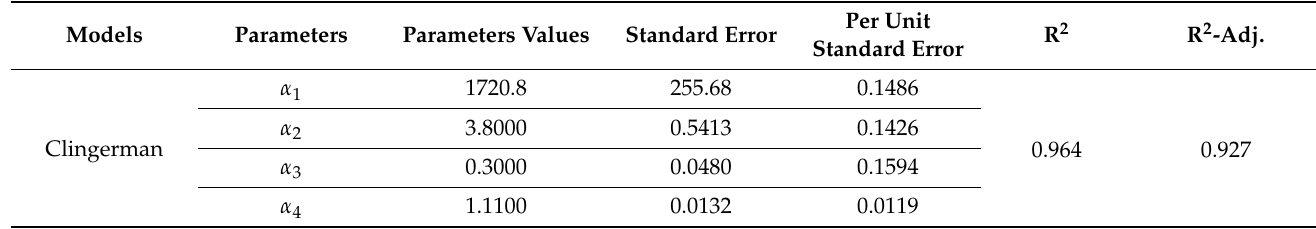
Table 2. Modified Clingerman model (MCM) parameters.